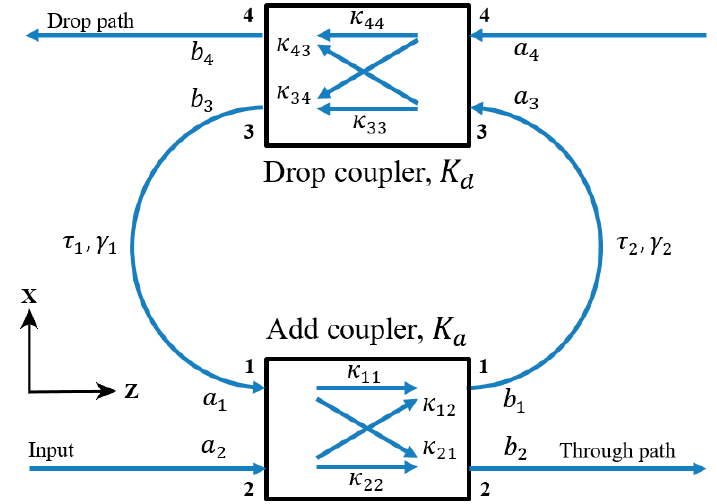
Figure 1. Model of a ring resonator with transmission and coupling